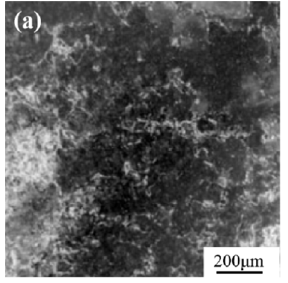
Figure 14. ( a ) TEM bright field of the dislocation organization in the copper base material; ( b ) bright ‐ field TEM micrograph showing the grain and the dislocation structures in the TMAZ in the copper side, close to the Al/Cu interface; ( c ) bright field showing the microstructure in the stir zone; ( d ) bright field of the grain structure in the TMAZ (adapted from [15], with permission from Springer, 2011).